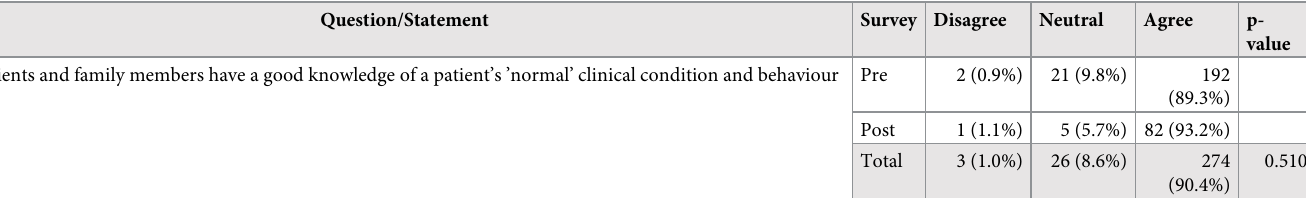
Table 1. Staff perceptions towards patients and family members identifying clinical deterioration and escalating